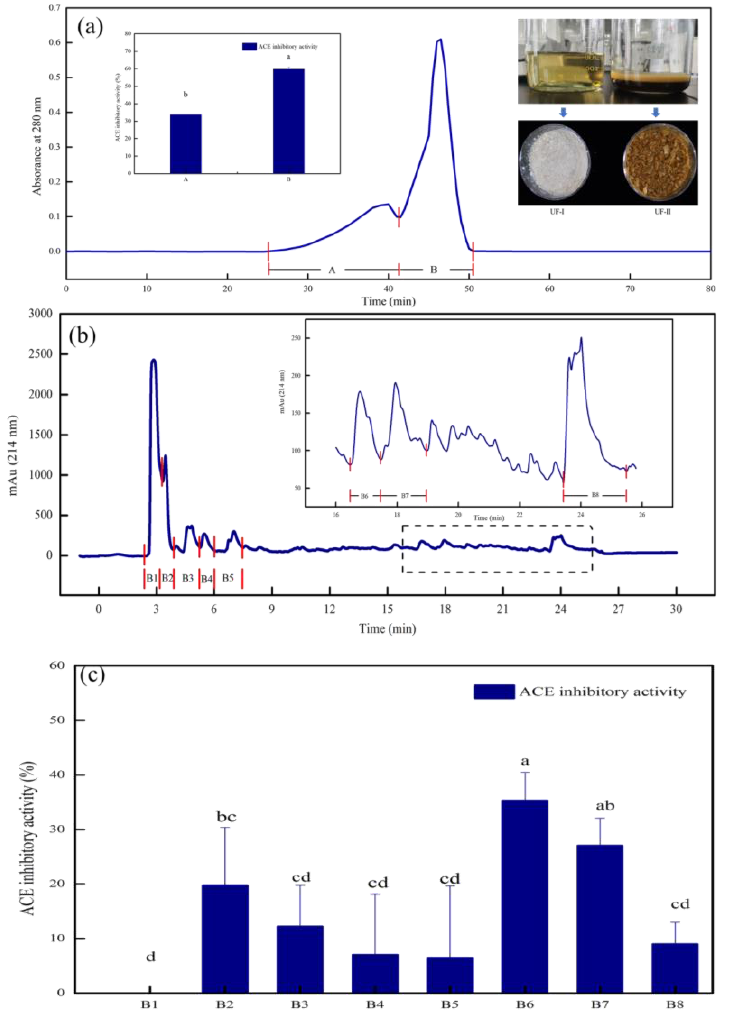
Figure 1. ( a ) Hydrolysates and powders of UF-I and UF-II. Sephadex G-25 size exclusion chromatography of peptide and ACE inhibitory activity of fractions obtained by size exclusion chromatography (sample concentration: 60 mg/mL). ( b ) RP–HPLC chromatography of fraction B (sample concentration: 20 mg/mL). ( c ) ACE inhibitory activity of fractions obtained by RP–HPLC (sample concentration: 1 mg/mL). Significant marks in the figure (lowercase letters a–d), containing the same letter means no significant difference ( p > 0.05).